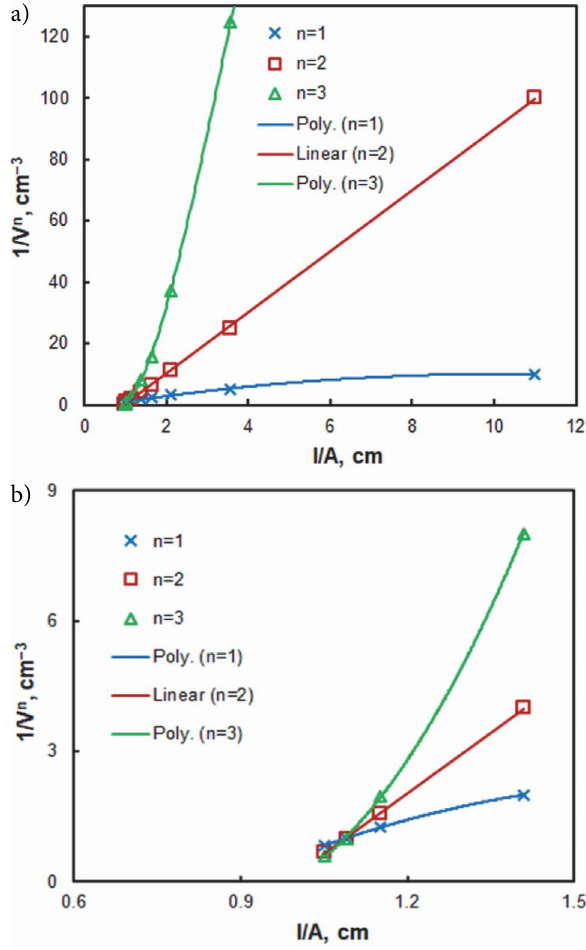
Figure 5. Determination of the MTAR/Ni II ( a ) and A336/Ni II ( b ) molar ratios by the straight-line method of Asmus. The experimen- tal conditions are given in Fig. 3 (series 2) and Fig. 4,